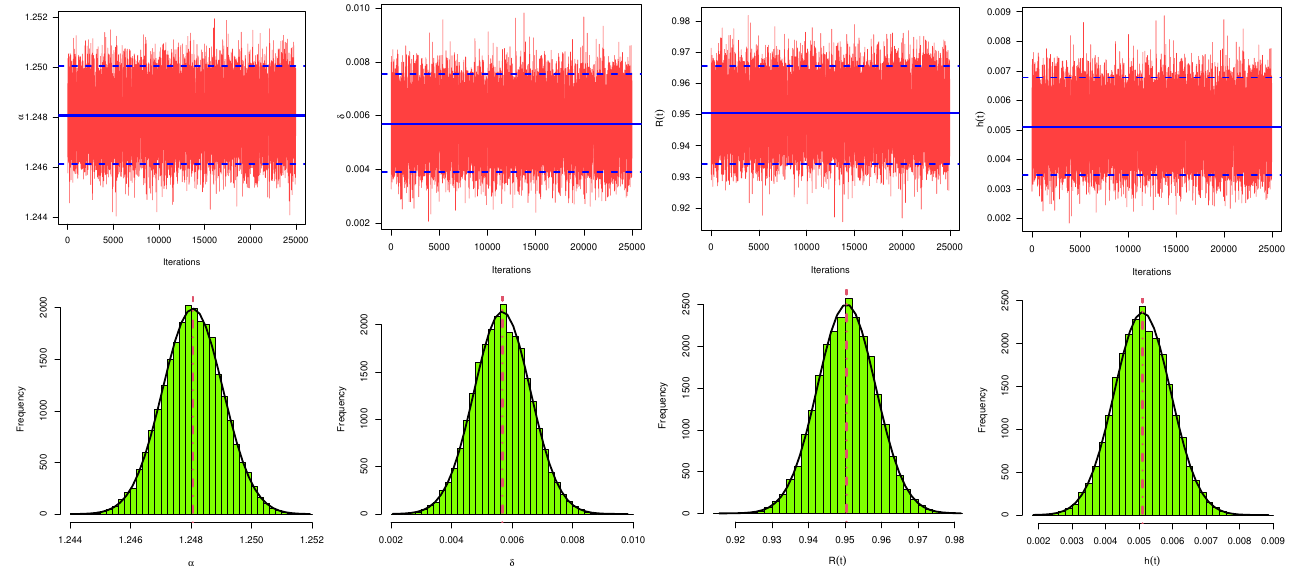
Figure 12. Trace (top-panel) and Histograms (bottom-panel) plots of α , δ , R ( t ) and h ( t ) from electronic devices